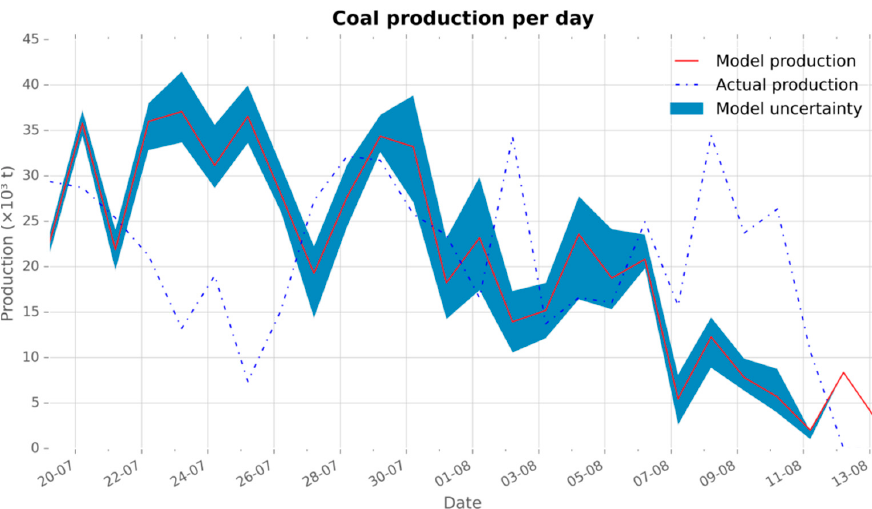
Figure 14. Comparison of daily production of coal, Experiment 2.